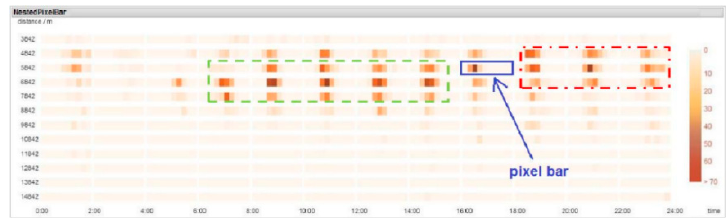
Figure 33. Columnar pixmap design [84].